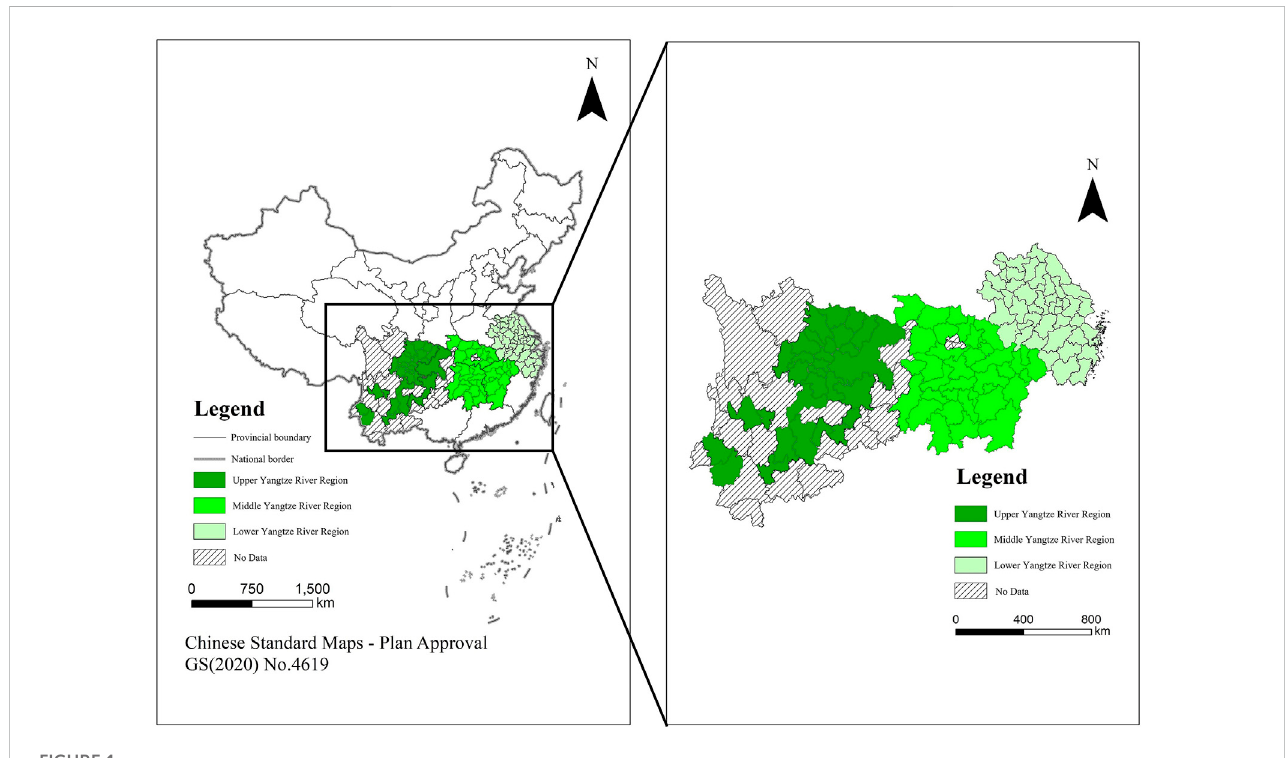
FIGURE 1 Study area.